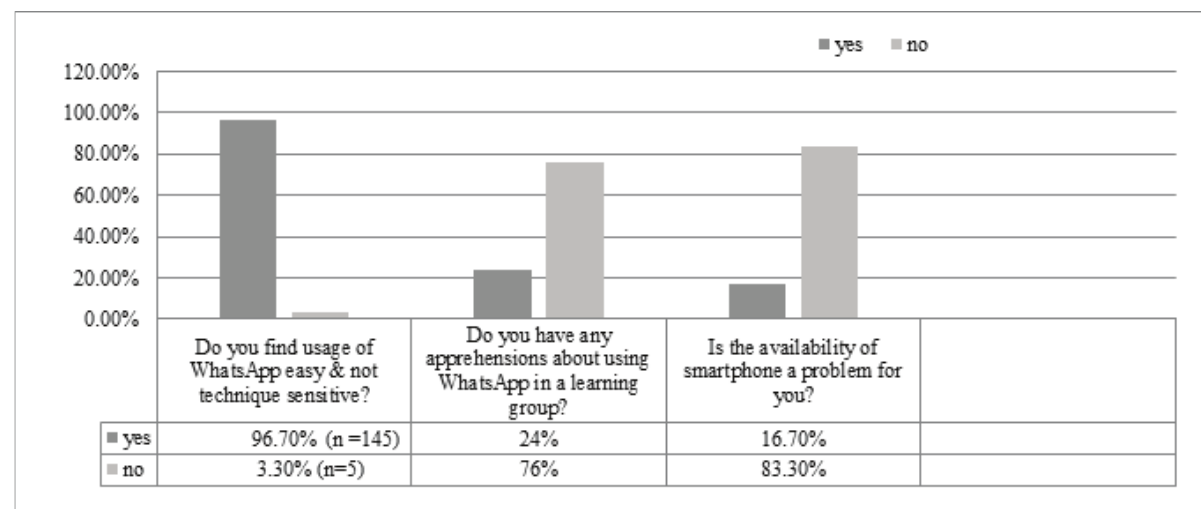
Figure I: Students' perception of the technological aspect of